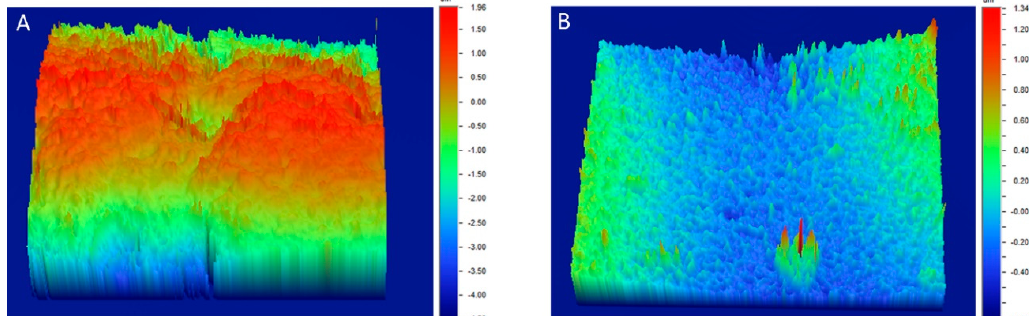
Figure 1. Representative 3D optical profilometric images from the control (CON) ( A ), and one-week (1W) and two-week (2W) groups ( B ). Please note the differences between scales.